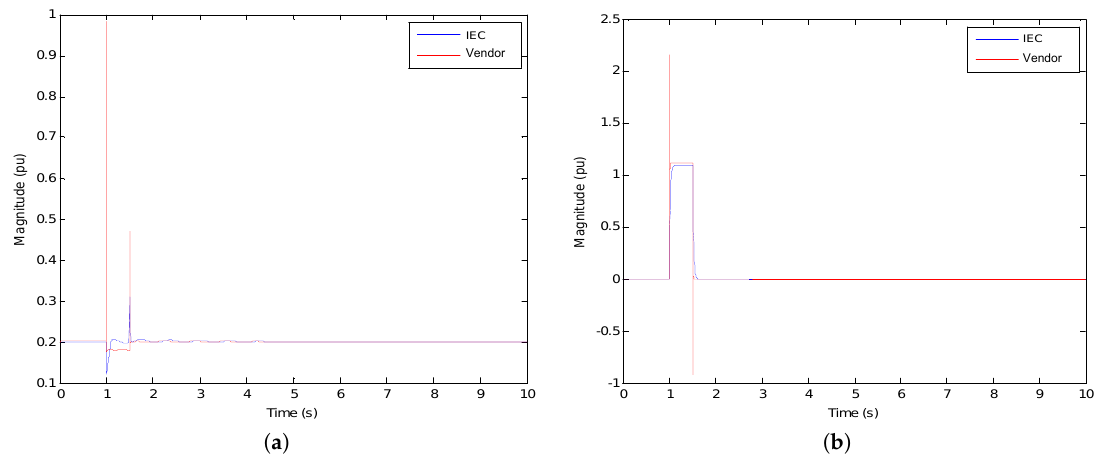
Figure 5. Type IIIB results. Simulation scenario: p = 0.20 pu, u = 0.50 pu, t = 500 ms. ( a ) Active power, p ; and ( b ) reactive current, i q .